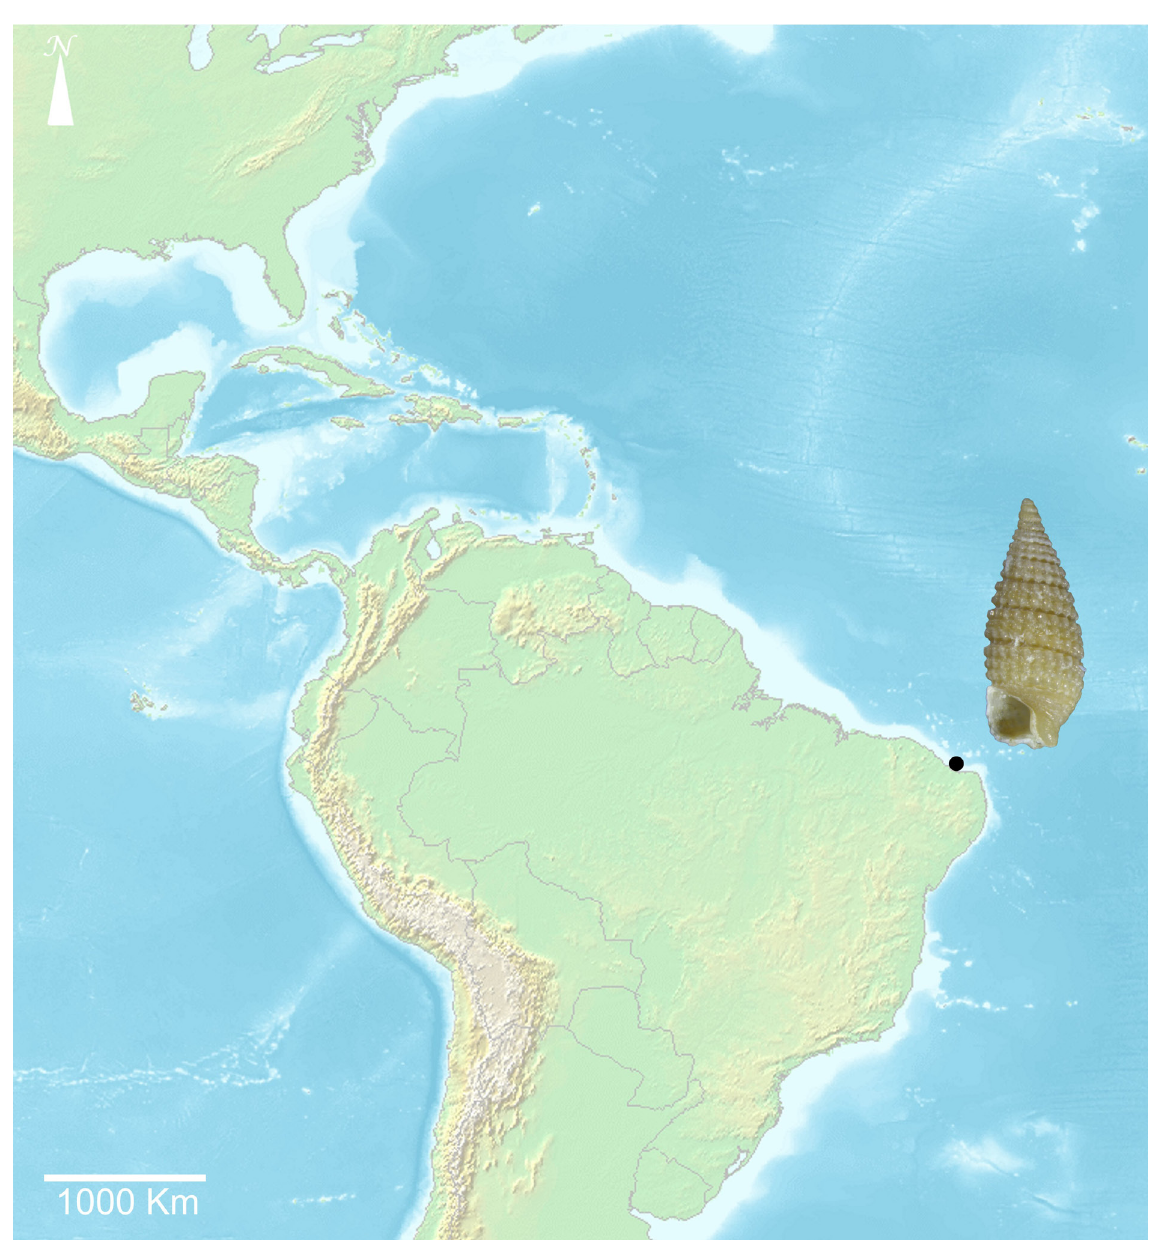
Fig. 60. Distribution map of Nanaphora sp.